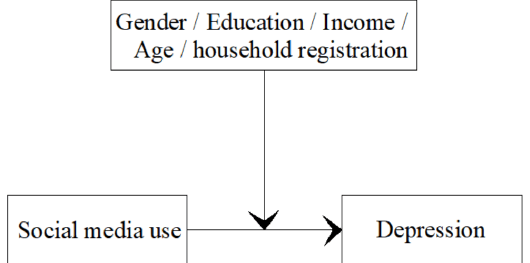
Figure 1. The model of the relationship between social media use and depression in different groups.